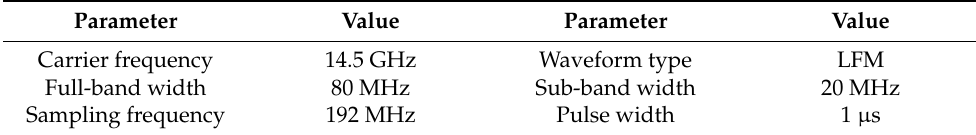
Table 1. Parameters of Waveform. Parameter Value